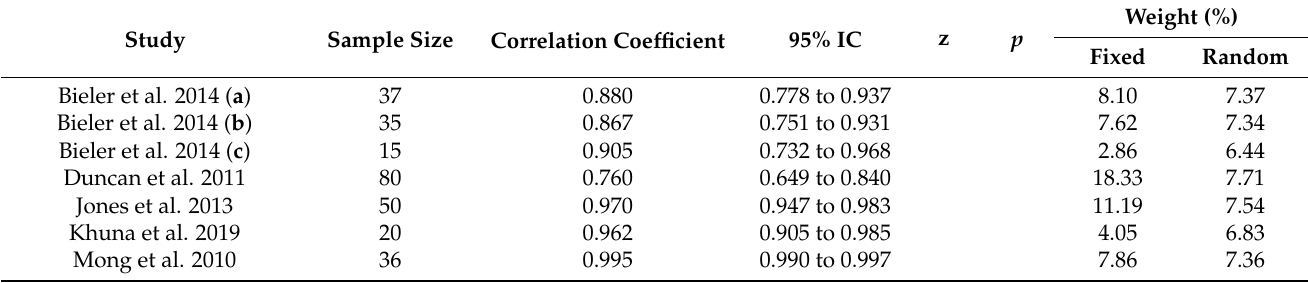
Table 2. Test-retest reliability meta-analysis (95% CI) for